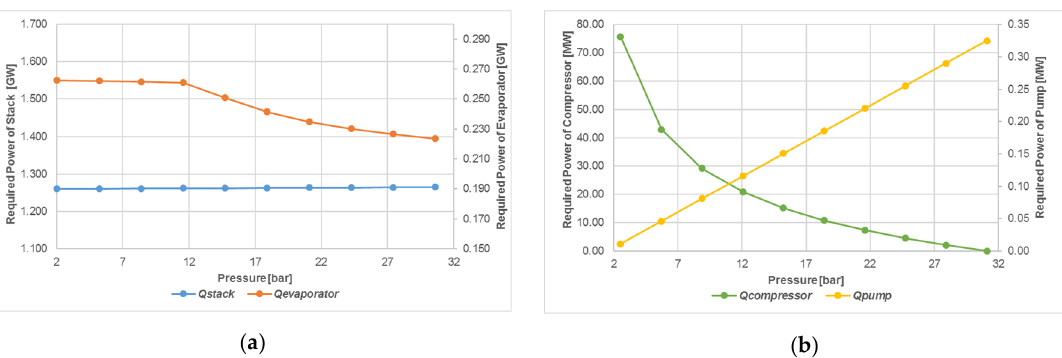
Figure 10. ( a ) Effect of pressure on required power for the operation of the stack and the evaporator for 10 kg/s H2 production; ( b ) Effect of pressure on required power of pump and compressor for 10 kg/s H2 production.